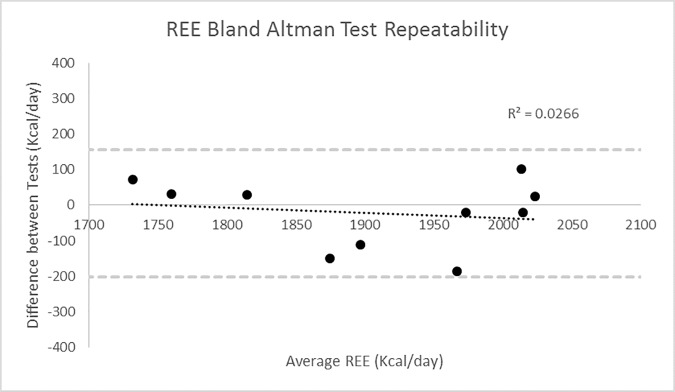
Repeatability of REE in Control Participants (n = 10), Day 1 vs Day 2.